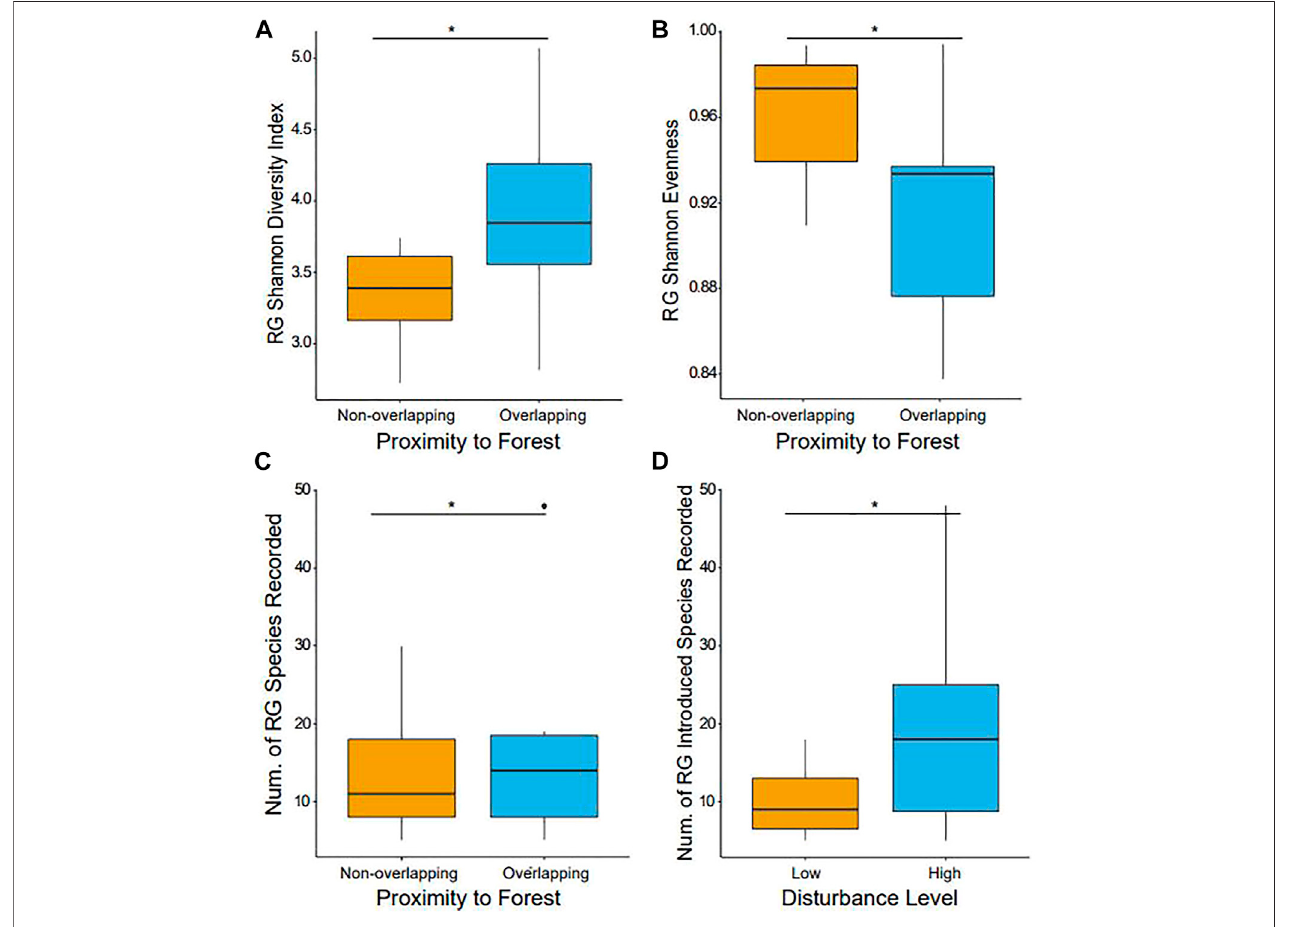
FIGURE 3 | Comparison of diversity measures for sites with different land use characteristics. (A) Shannon diversity index of research grade observations, (B) evenness of research graph observations, (C) number of research grade species, and (D) number of research grade introduced species are shown.